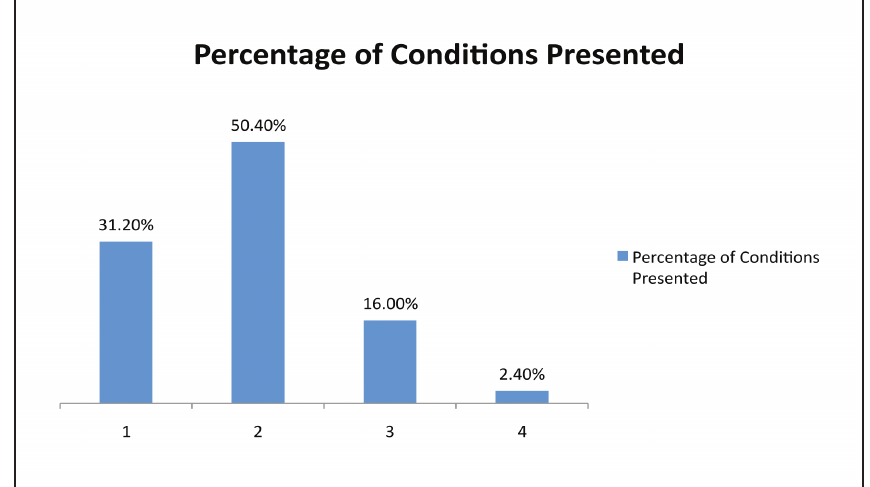
Figure 3: Distribution of the percentage of conditions presented